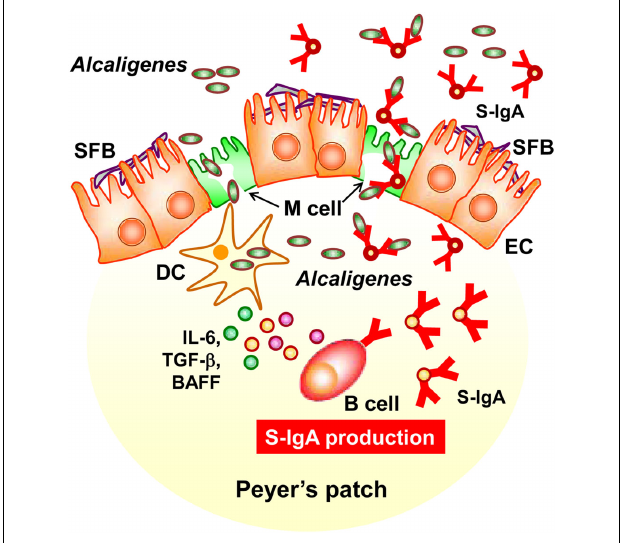
FIGURE 3 | Alcaligenes mediates symbiotic communication inside Peyer’s patches. On the follicle-associated epithelium of PPs, segmented filamentous bacteria (SFB) is predominantly observed. In contrast, Alcaligenes specifically localizes inside Peyer’s patches, where some are taken up by dendritic cells (DCs). Stimulation by Alcaligenes prompts the DCs to produce IgA-enhancing cytokines [e.g., interleukin-6 (IL-6), transforming growth factor- β (TGF- β )], and B cell activating factor (BAFF), which enhance the intestinal IgA response.The intestinal IgA includes Alcaligenes -specific IgA, which might mediate the preferential uptake and presence of Alcaligenes in the PPs.The uptake is presumably mediated by M